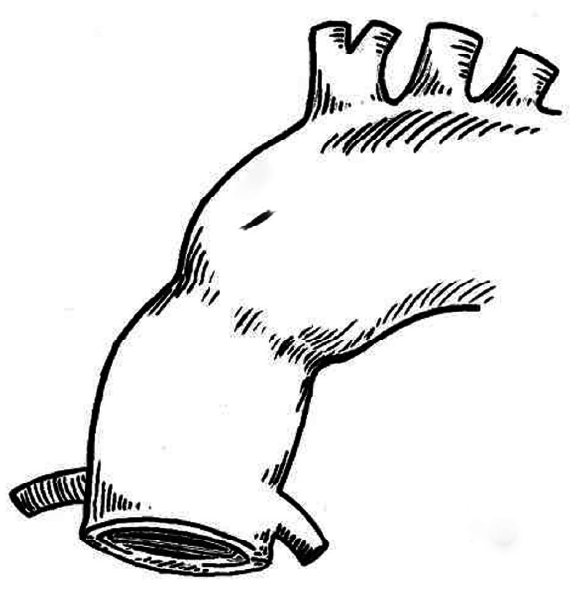
Fig. 1 – Ilustração da estenose supra-aórtica